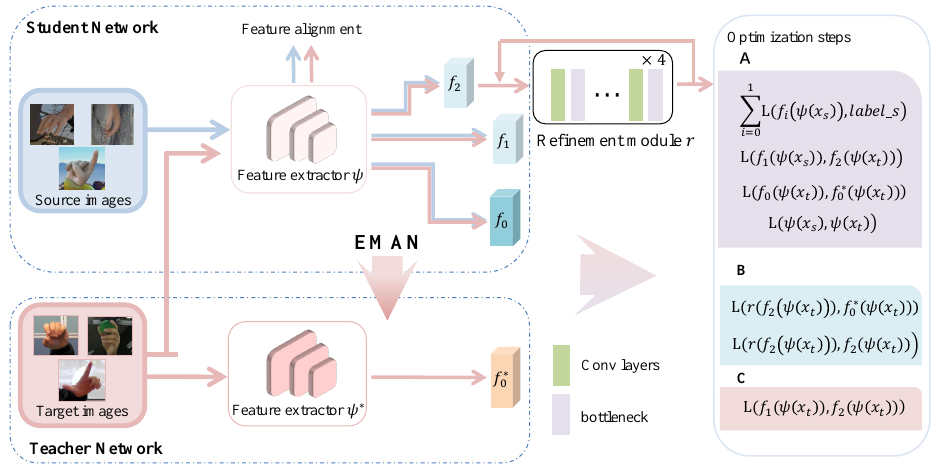
Figure 2. Our network is a student–teacher architecture, where the student network consists of a feature extractor, three regressors, and a refine module. The source and target images are fed into the student network, while the target images are fed into the teacher network. In addition, The teacher network also has three regressors, but the regressors f ∗ regressors and f 1 in the student network, are not used during training and testing, so we do not draw